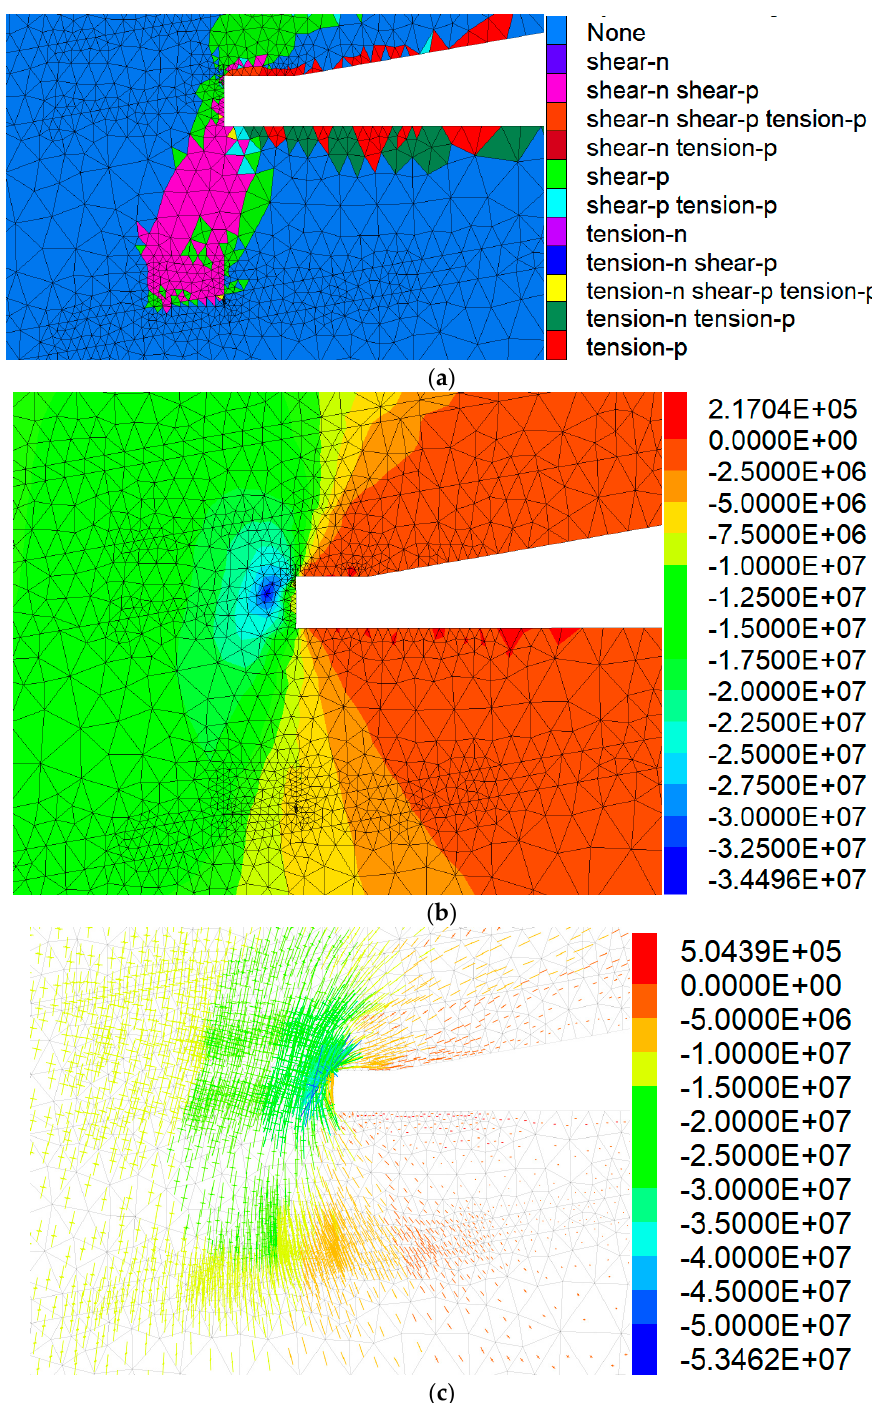
Figure 9. Surrounding rock stability with 10.5 m height of stagger arrangement mining. ( a ) Plastic zone; ( b ) Abutment vertical stress distribution; ( c ) Principal stress distribution. zone; ( b ) Abutment vertical stress distribution; ( c ) Principal stress